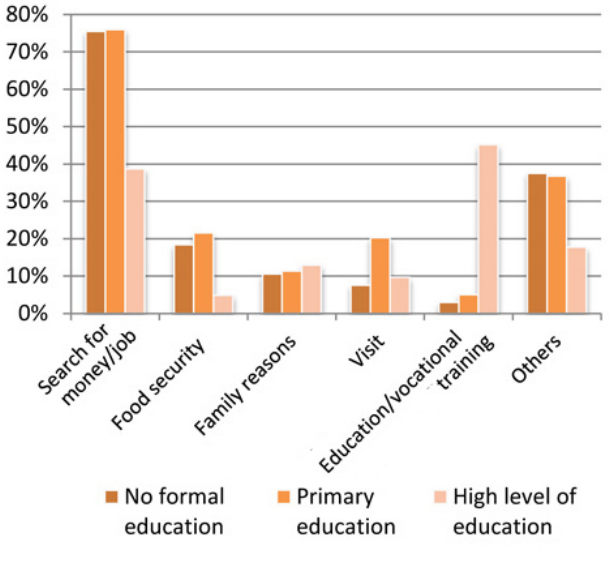
Fig. 3. Main motives behind people’s last migration, depending on their education